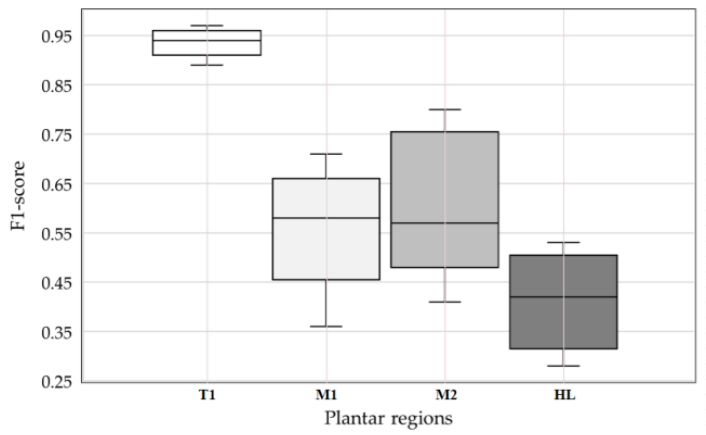
Figure 6. Result of the ANN model F-score in 5-fold cross-validation. Meanwhile, the dataset of HL generates a lower performance compared to the other three datasets. The T1 region is more dominant in walking or running movements, es- pecially during the pre-swing phase but has a thinner tissue thickness [9,50]. Repeated pressure on these soft tissues causes the T1 region to have a greater potential for foot ulcers. Visually, the global data used in this study are often at the boundary of the criteria for classifying foot plantar images, which is somewhat ambiguous in features, resulting in poor performance compared to if the image is analyzed regionally. Therefore, a deep analysis through regional feature extraction is needed to ensure that the plantar patterns can be extracted consistently. The main finding of this study is that the dataset on the T1 region achieves the best performance with the highest accuracy and minor variance. Thus, it can be seen that analysis of plantar region pressure images is essential to increase the classification performance of walking speed and walking